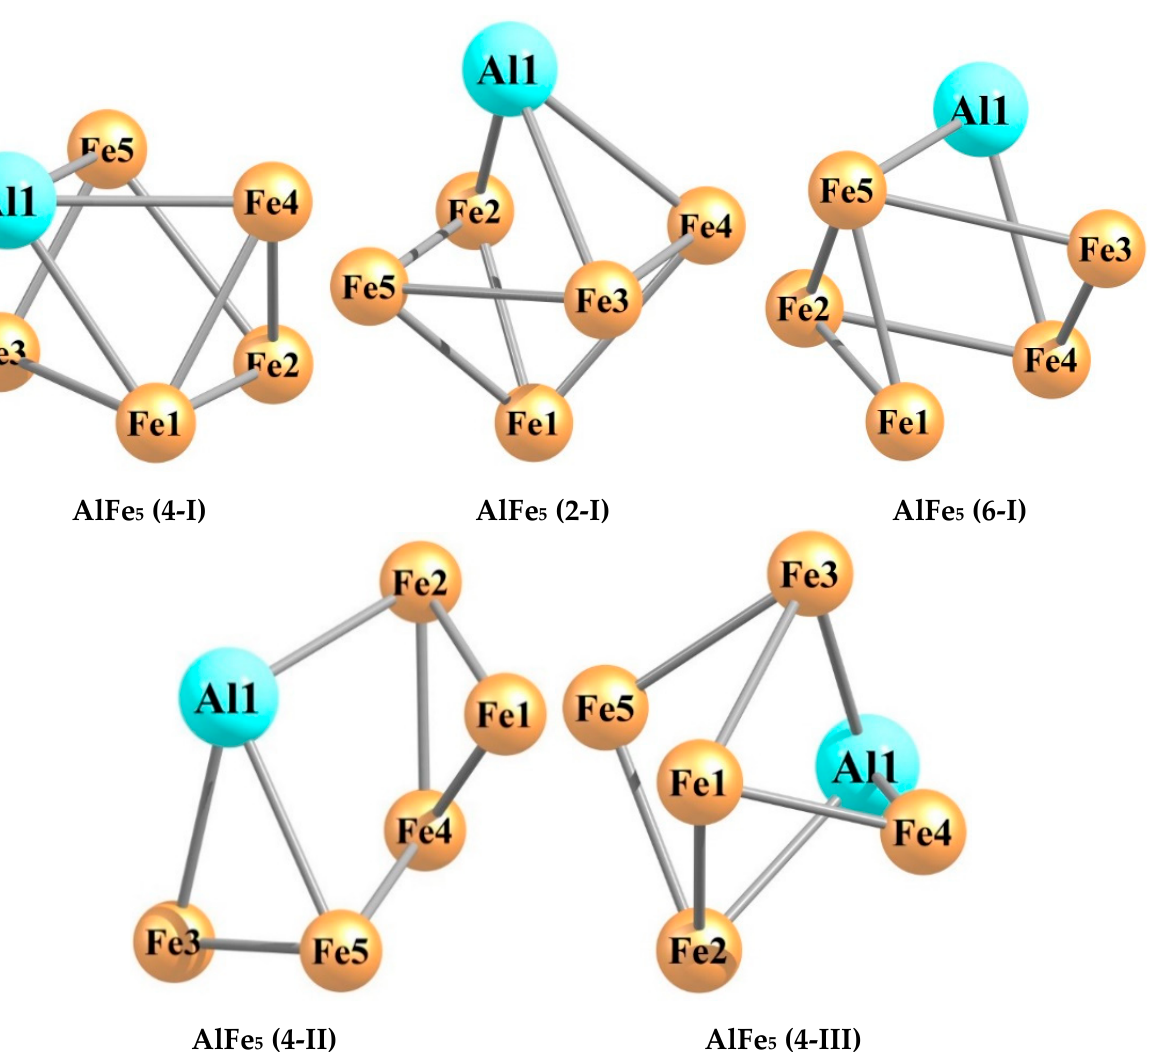
Figure 5. Molecular structures of the five most energetically stable AlFe 5 metal clusters.